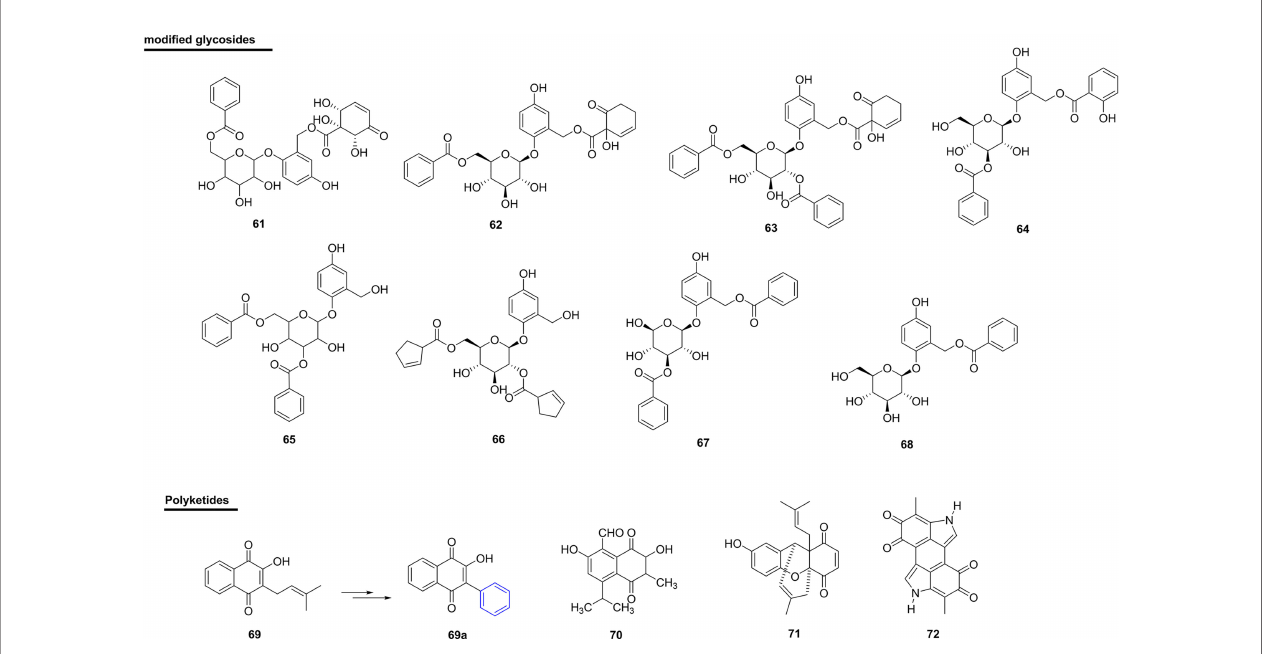
FIGURE 7 | Chemical structures of snakebite treatment compounds 61-72